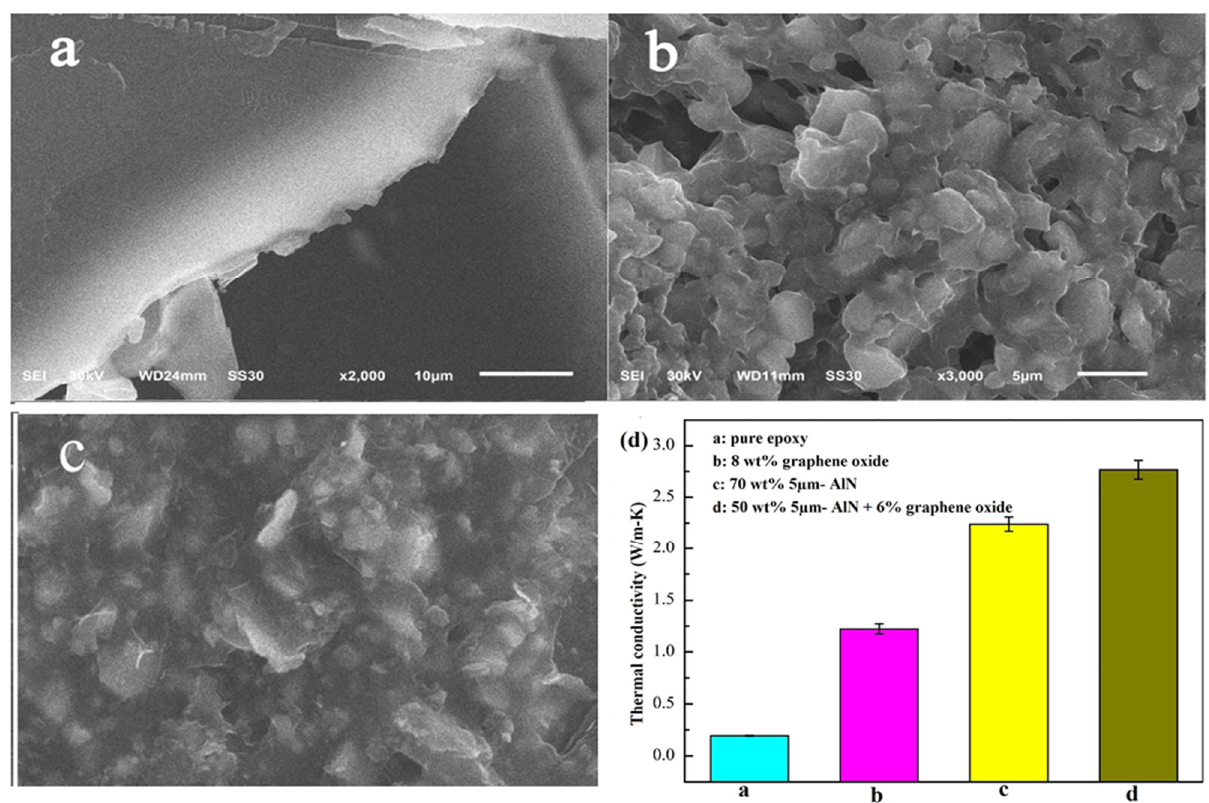
Figure 7. SEM images of epoxy adhesives containing ( a ) only epoxy resin, ( b ) epoxy with AlN particles, ( c ) epoxy with AlN and GO hybrid filler and ( d ) Thermal conductivity of different test samples [65].